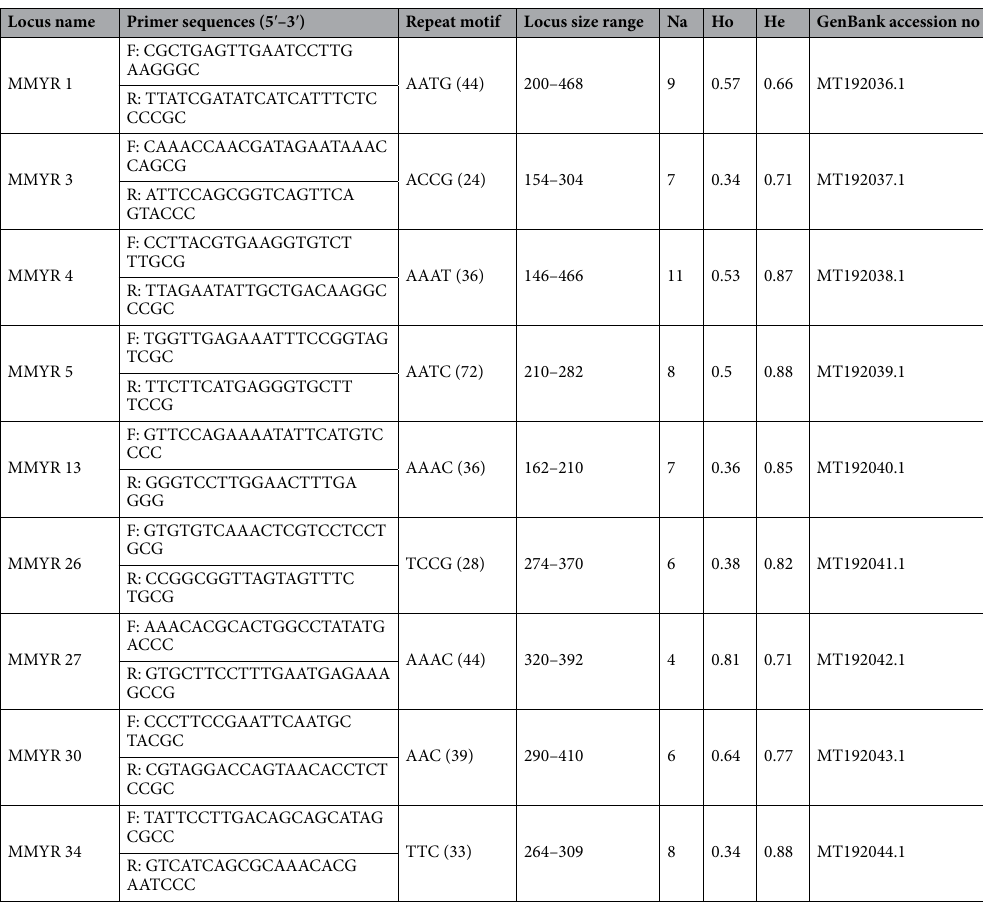
Table 1. Locus information for the primers of M. myriaster with best quality of amplification. Na: Allele number per locus. Ho: Observed heterozygosity. He: Expected heterozygosity.